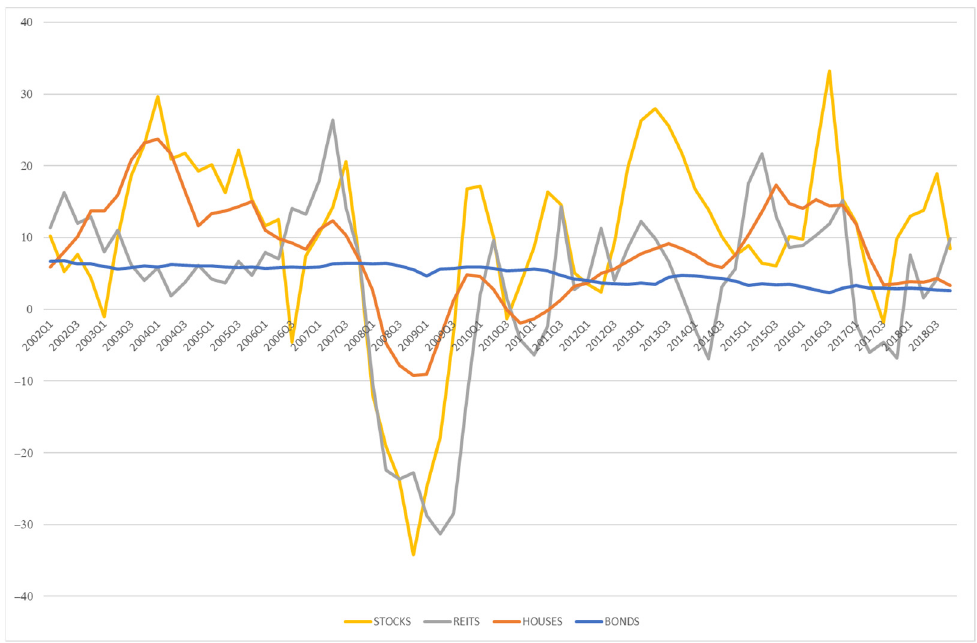
Figure 1. The Annual Price Returns of Stocks, REITs, Bonds and Houses in New Zealand, 2002–